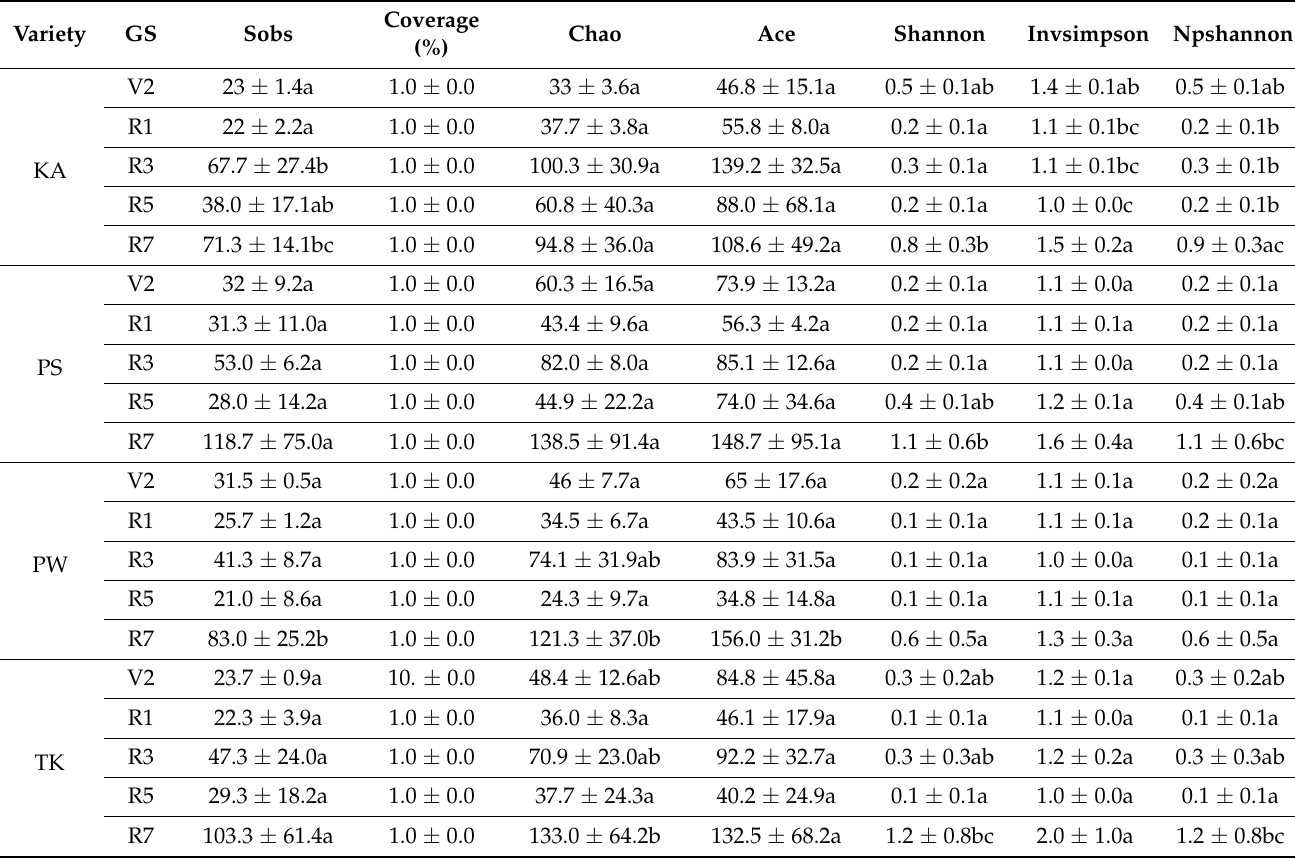
Table 2. Diversity indices of bacterial community in the root nodule of 4 varieties of